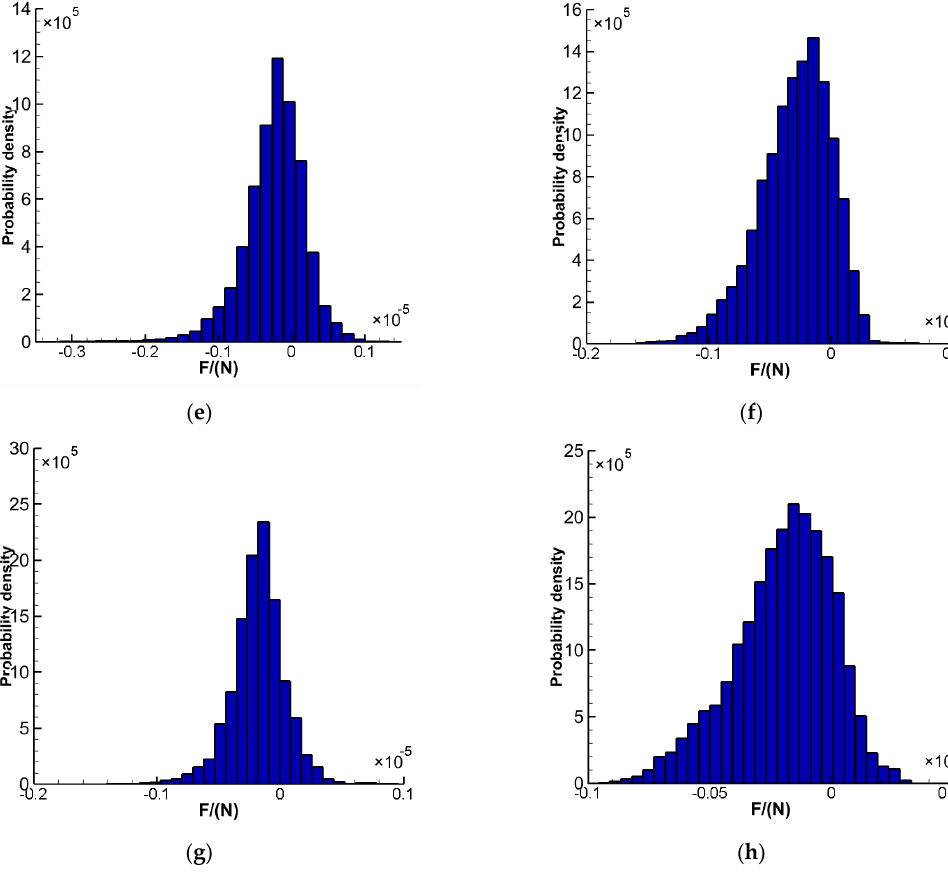
Figure 15. Probability density distribution of F y ( a ) Sensor 1; ( b ) Sensor 2; ( c ) Sensor 3; ( d ) Sensor 4; ( e ) Sensor 5; ( f ) Sensor 6; ( g ) Sensor 7; ( h ) Sensor 8.